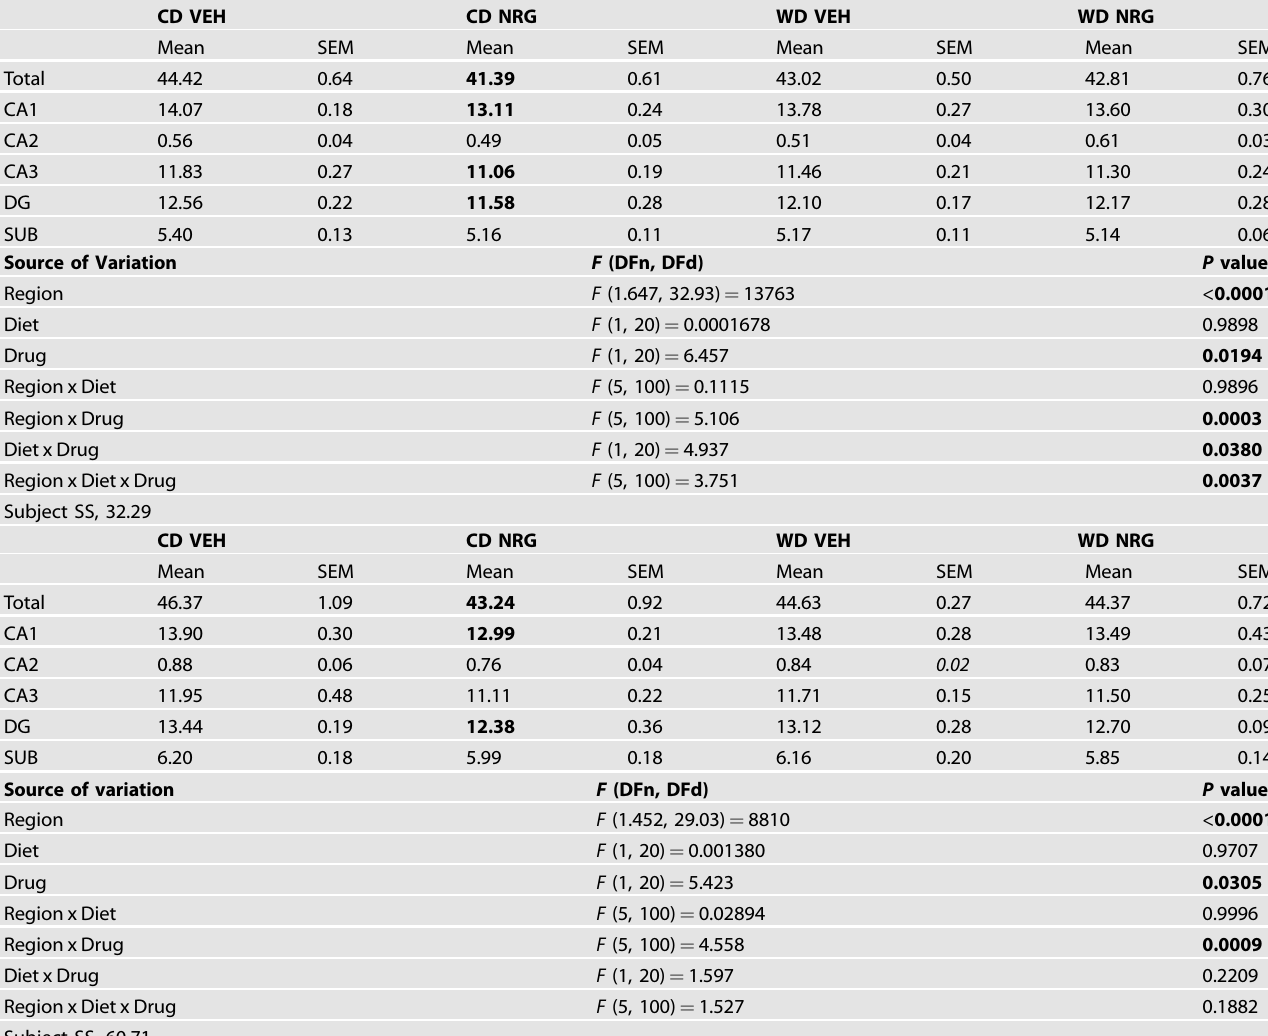
Table 2. A Detailed right hippocampal sub fi eld volumetrics and statistics. B Detailed left hippocampal sub fi eld volumetrics and